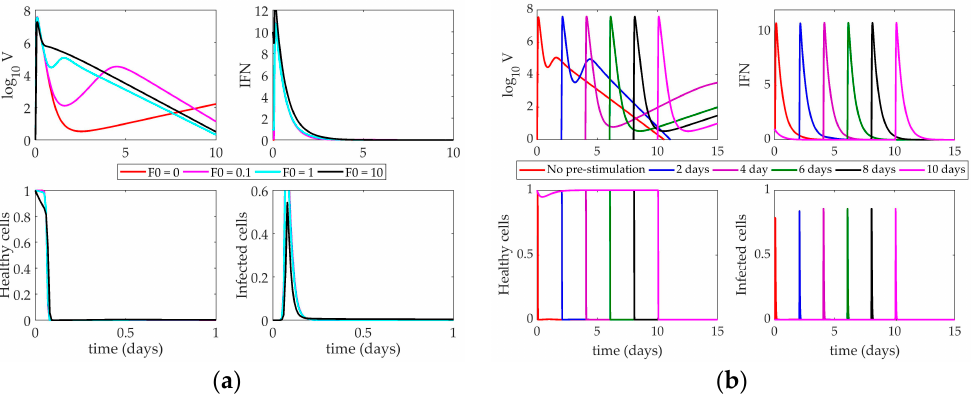
Figure 5 Figure 5. ( a ) Response of Pawelek model to increasing interferon (IFN) on day 0. Lines correspond to different values of F0 (initial condition of interferon); ( b ) Impact of IFN pre-stimulation scheduling on the Pawelek model. IFN treatment is given on day 0 and patients are simulated to become infected 2, 4, 6, 8, or 10 days after